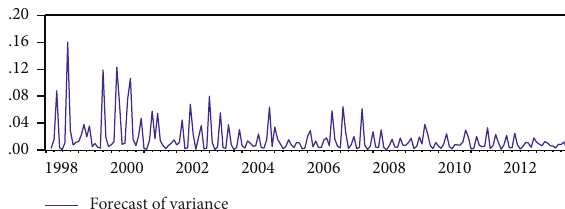
Figure 4: In-sample forecast of monthly price volatility of silver using the EGARCH(3, 2) volatility